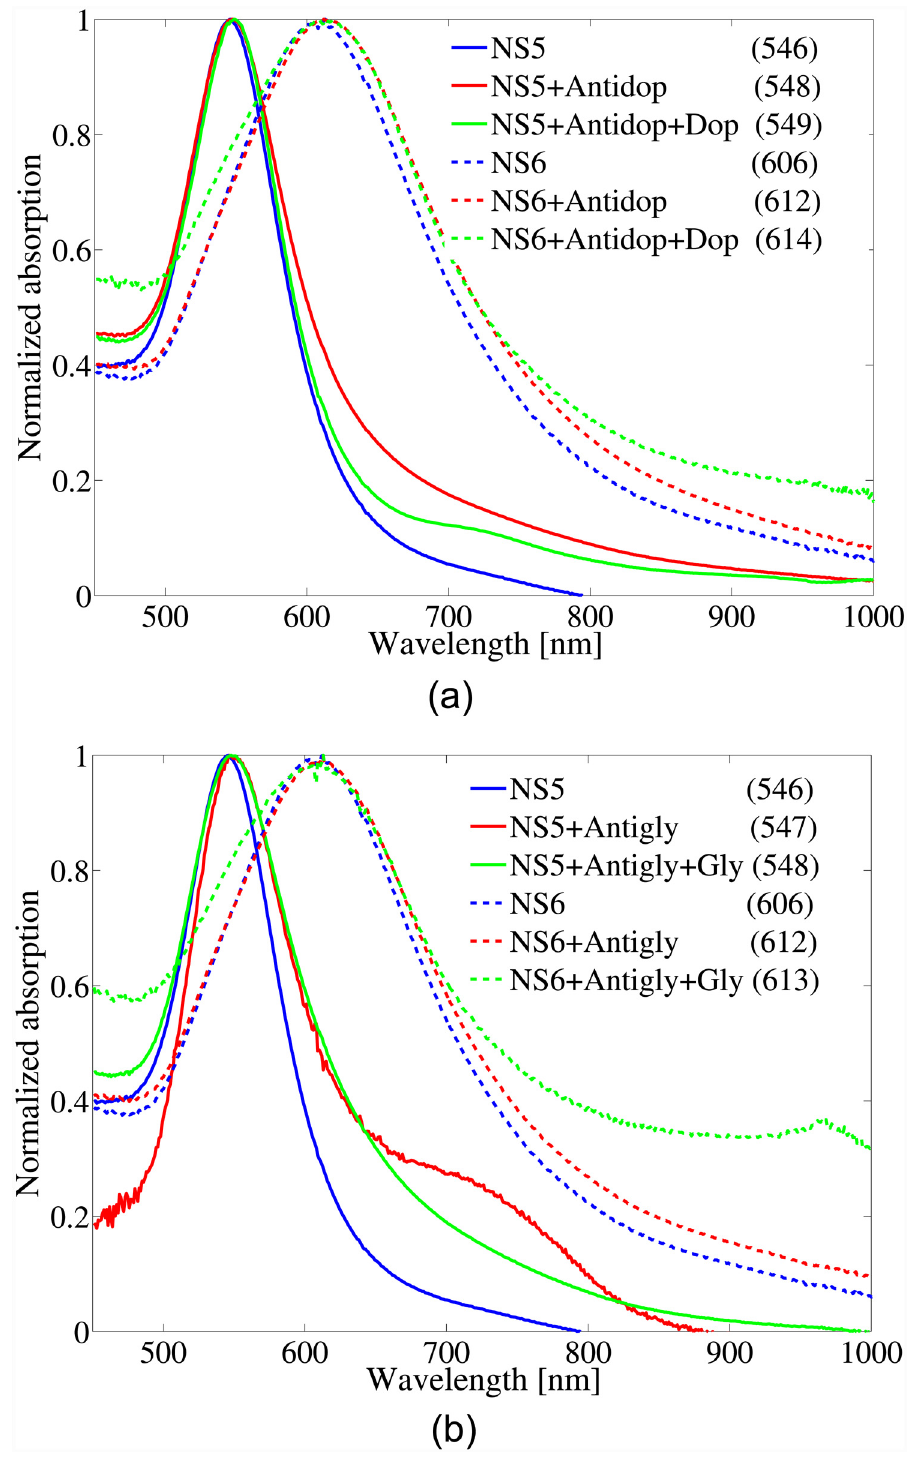
Fig 4. The standard results set for NS5 and NS6 nanospheres using a) Antidop as the receptor and Dop as the neurotransmitter, and b) Antigab as the receptor and Gab as the neurotransmitter. The numbers in parenthesizes report the peak wavelength of each curve in units of nm